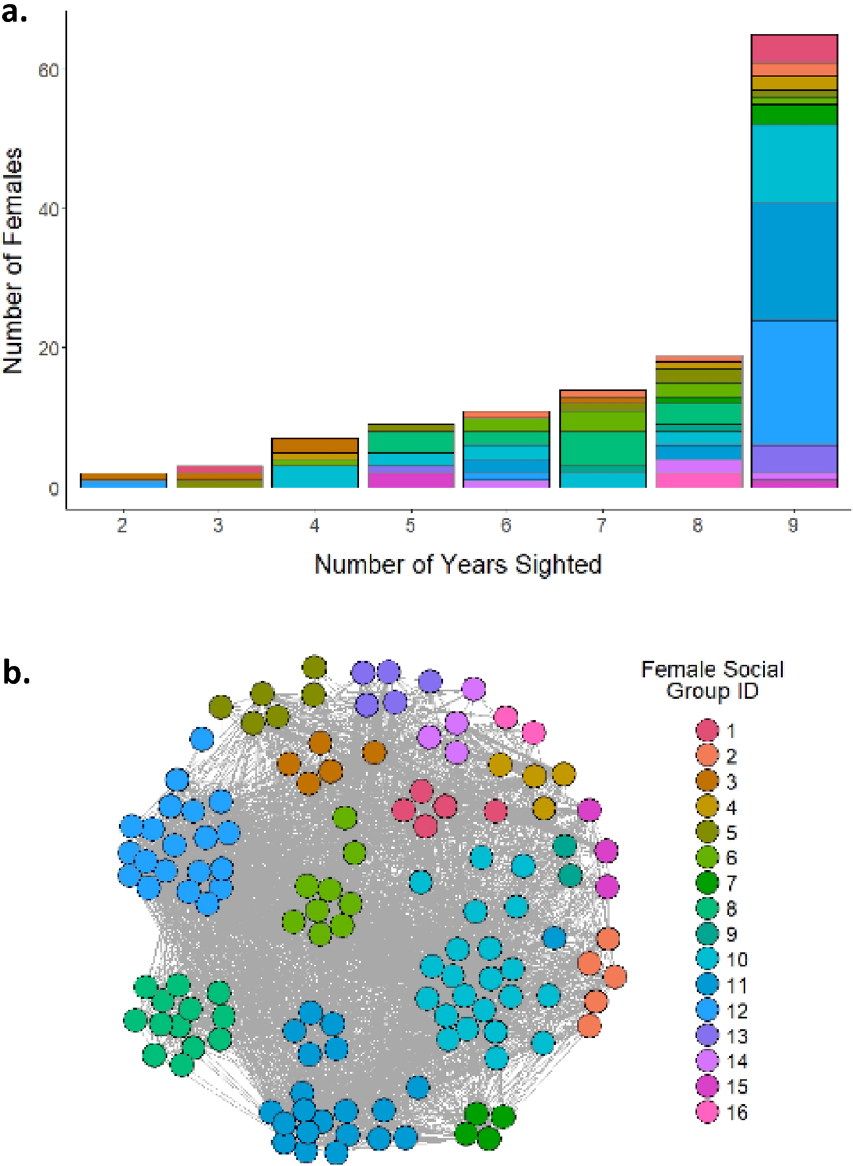
Figure 4. Sightings and social affiliations of adult females (n = 130). ( a ) Individuals were required to be seen in both of the first years of the study in order to be included in our sample but half (65 individuals) were seen across all nine. Colors indicate community assignment; individuals from the same community differ in how frequently they were seen. ( b ) Community size and